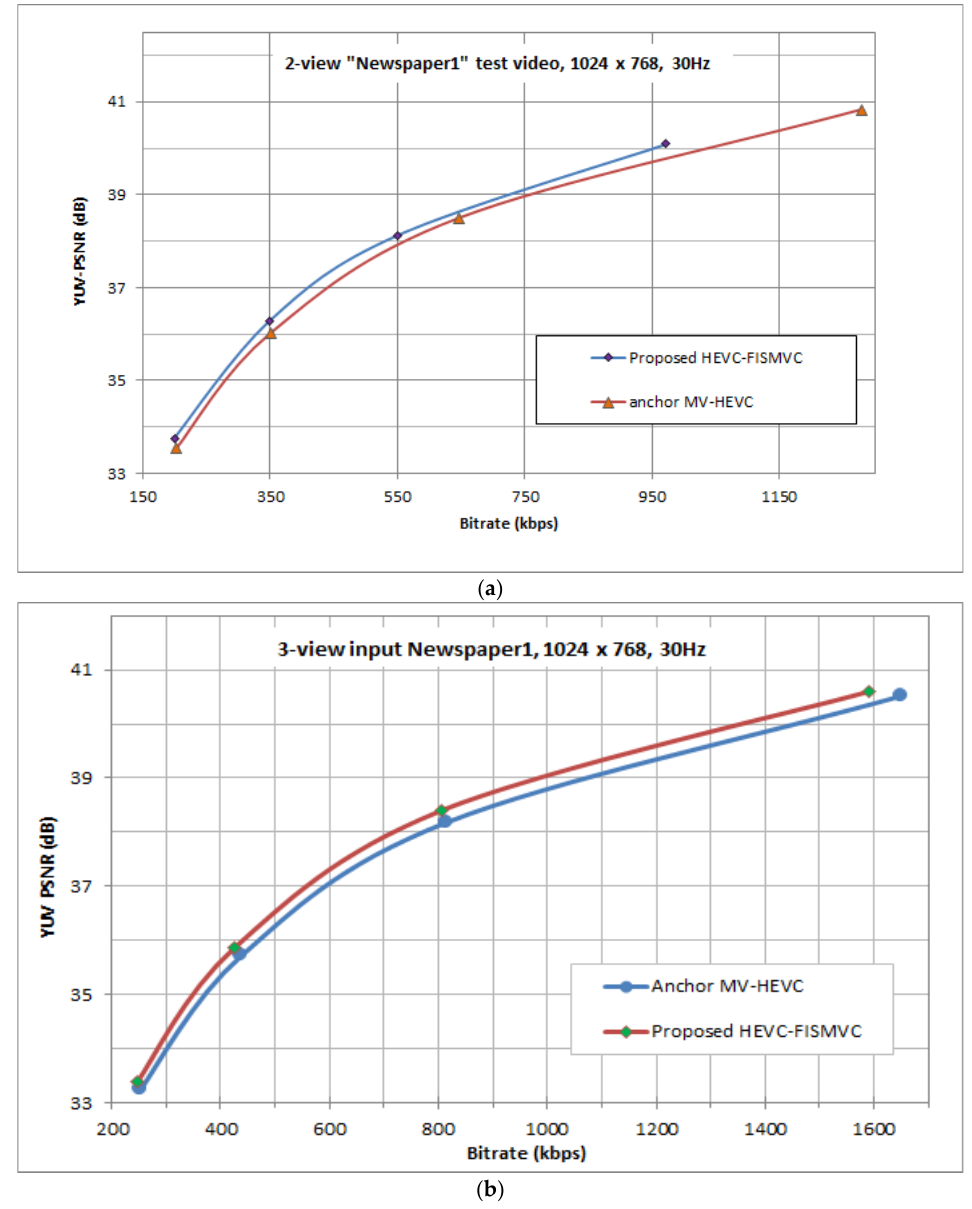
Figure 6. Average YUV-PSNR vs bitrate for the anchor MV-HEVC and the proposed HEVC-FISMVC codecs when coding: ( a ) 2-view “Newspaper1” and ( b ) 3-view “Newspaper1” multiview videos. Table 2. BD-PSNR of the proposed single-layered stereo video codec with respect to the anchor MV- HEVC codec.